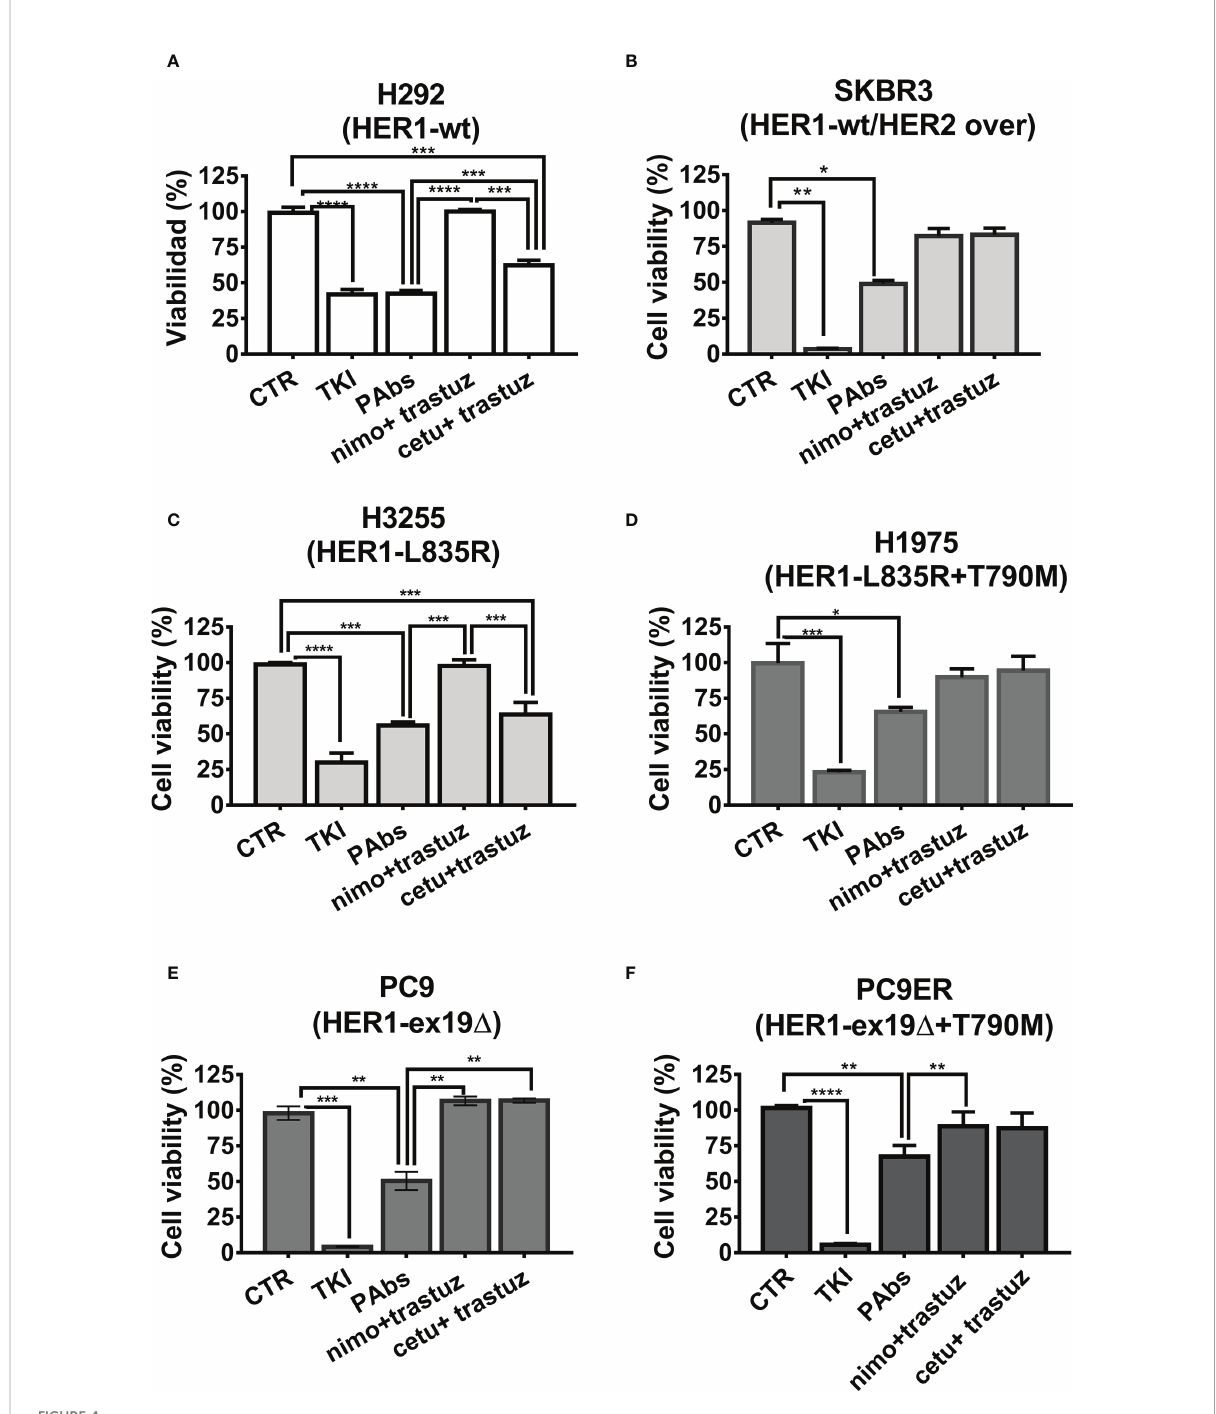
FIGURE 4 Inhibition of tumor cell viability. Cells were treated with PAbs (10 µg/ml) or with the combination of cetuximab (cetu, 10 µg/ml) or nimotuzumab (nimo, 10 µg/ml) with trastuzumab (trastuz, 1 µg/ml). Unspeci fi c PAbs (CTR, 10 µg/ml) or speci fi c TKI AG1478 (in the case of H292 and A549 cells, 10 µM), lapatinib (in the case of SKBR3 20 µM), or osimertinib (for HER1-mutated lines cells,1 µM) was included as negative and positive controls, respectively. After 72 h of treatment, the viability of (A) H292, (B) SKBR3, (C) H3255 (L835R), (D) H1975 (L835R/T790M), (E) PC9 (exon19 deletion), and (F) PC9ER cells (exon 19 deletion and T790M mutation) was evaluated by MTT. In the graphs, data are means ± SD of triplicates in one experiment representative of at least two conducted, for each cell line. Differences among means, when normality and variance homogeneity were con fi rmed, were analyzed using one-way ANOVA, and Tukey test was used for multiple comparisons. Alternatively, non- parametric Kruskal – Wallis test was conducted, followed by Games – Howell post-test. Signi fi cant differences among negative control PAbs and the treatments as well as among speci fi c PAbs and MAbs combinations are represented * p < 0.05; ** p < 0.01; *** p < 0.001; **** p <